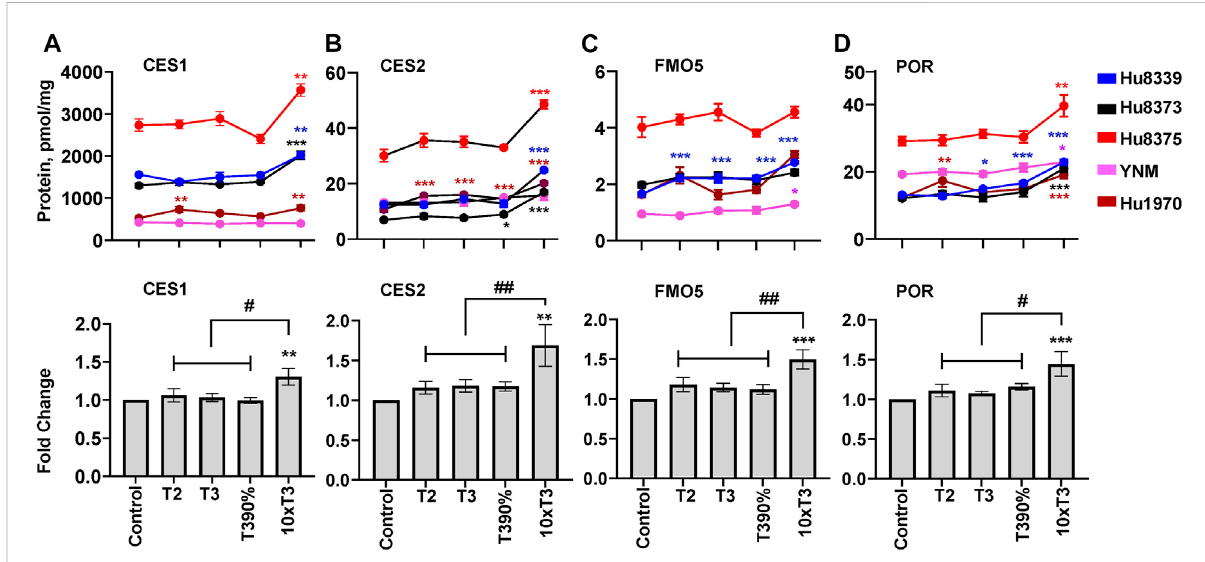
FIGURE 5 PRHs increased the absolute protein concentration of other key DMEs in SCHH. Human primary hepatocytes from quali fi ed donors were exposed to vehicle control or PRH cocktails. The PRH cocktails target average trimester 2 (T2), average trimester 3 (T3), upper range of T3 (T3-90%), and supraphysiological (10xT3) PRH concentrations (Table 1). The line graphs represent mean ± SEM absolute protein concentration of CES1 (A) , CES2 (B) , FMO5 (C) , and POR (D) in SCHH in response to exposure to PRHs within each hepatocyte donor ( n = 3 – 4 biological replicates per group). The bar graphs below represent mean ± SEM fold-change for each protein relative to control across all donors ( n = 5 per group). * p < 0.05, ** p < 0.01, *** p < 0.001 versus control. #Represents concentration-dependent effect across PRH groups (# < 0.05, ## <